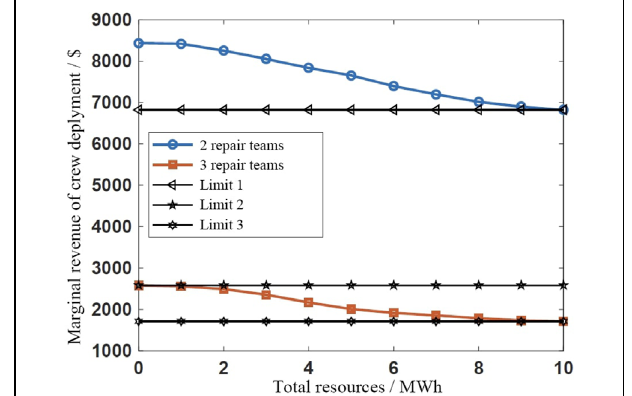
FIGURE 13 | Marginal revenue of repair team deployment (100